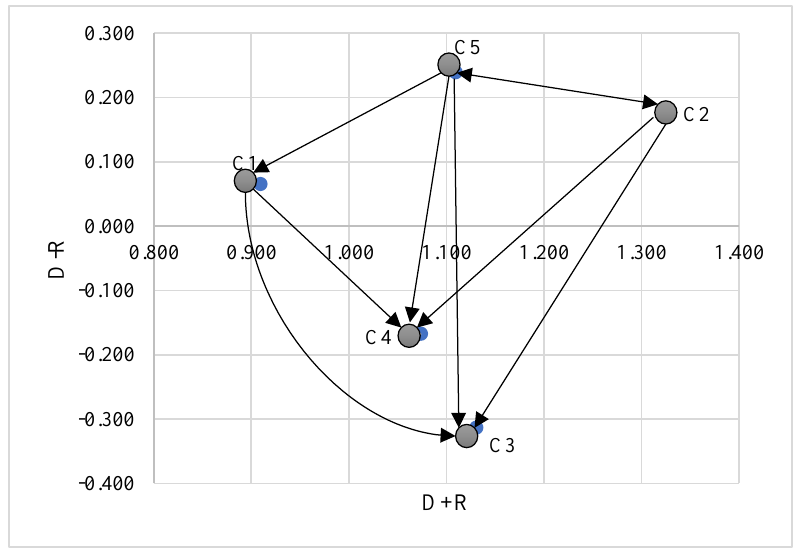
Figure 5. Causal diagram of the main factors (Symbol criteria are presented in Tables A2 and A3). Table 5. Final weights of criteria and